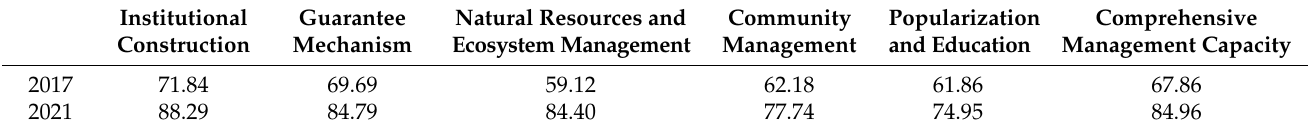
Table 6. Comprehensive management capacity scores of TNP in 2017 and